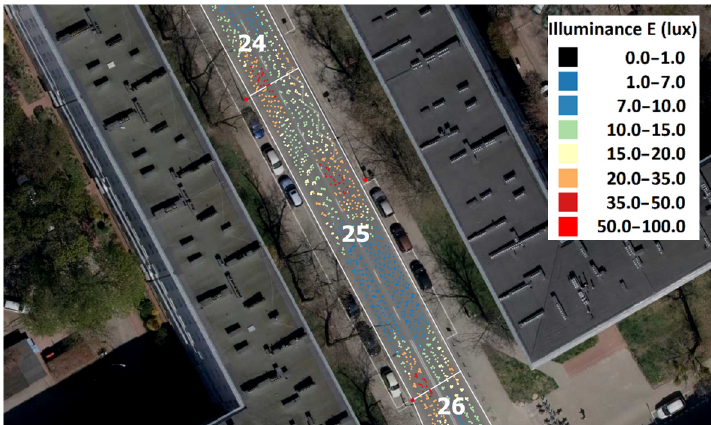
Figure A10. Example of five illuminance measurements in field No. 25.